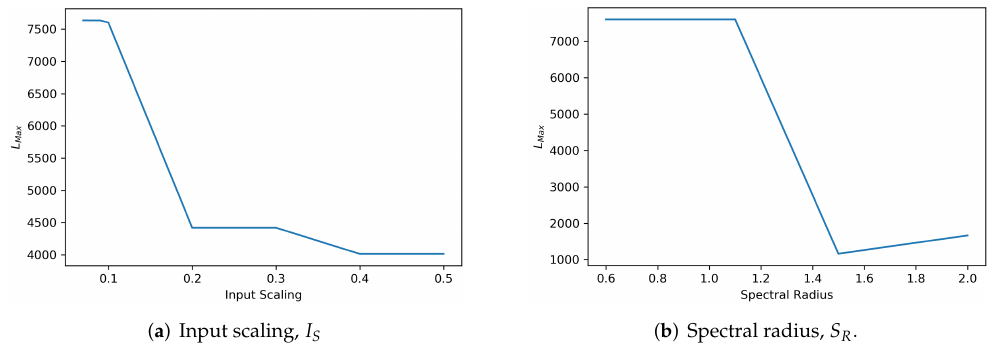
Figure 8. Results on the MSRA3D dataset. Measured reservoir stability, L MAX against different hyperparameter settings.